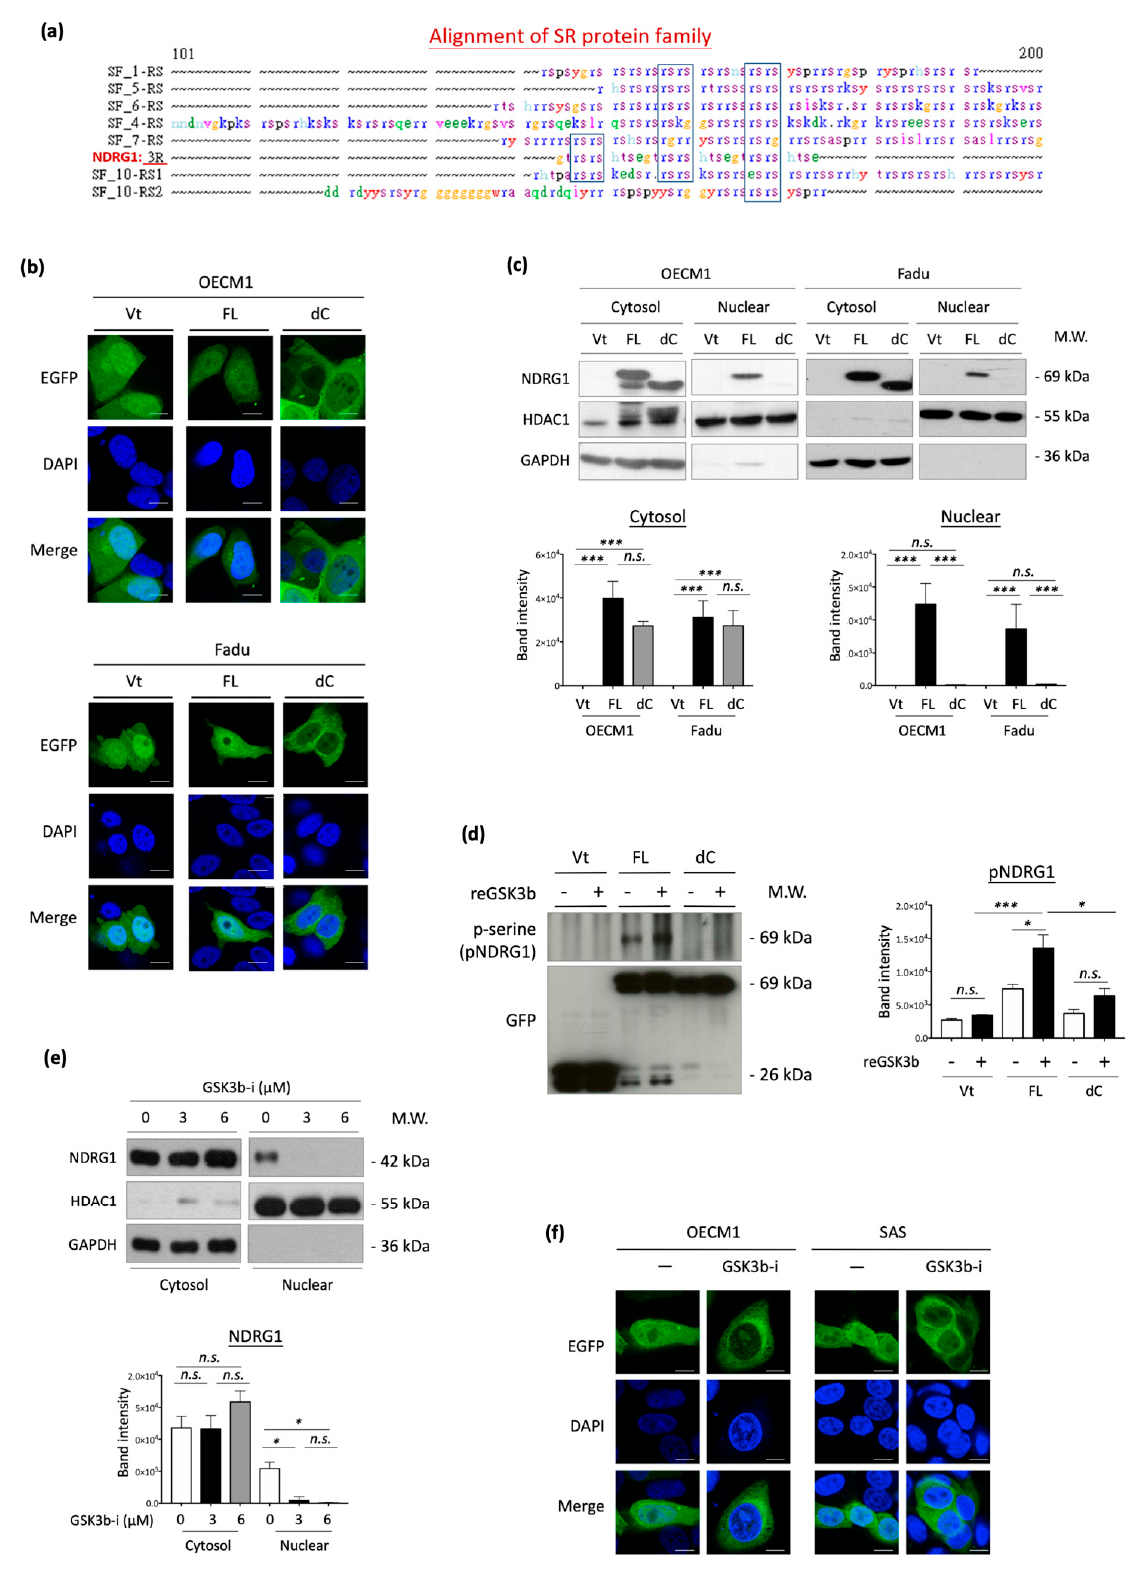
Figure 6. The 3R-motif of NDRG1 is actioned for nuclear translocation and phosphorylation. ( a ) Sequence homology of NDRG1-3R motif with SR protein family. The sequences of 3R motif and SR family proteins were aligned using Pileup program in Chang Gung University. The conserved amino acids are blocked in the indicated boxes. ( b ) Depletion of NDRG-3R motif significantly inhibited